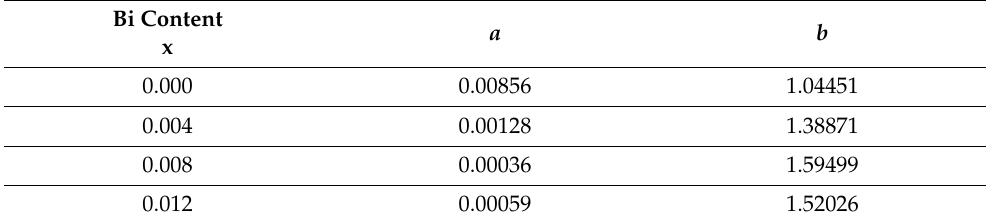
Table 6. Parameters obtained from power law (Equation